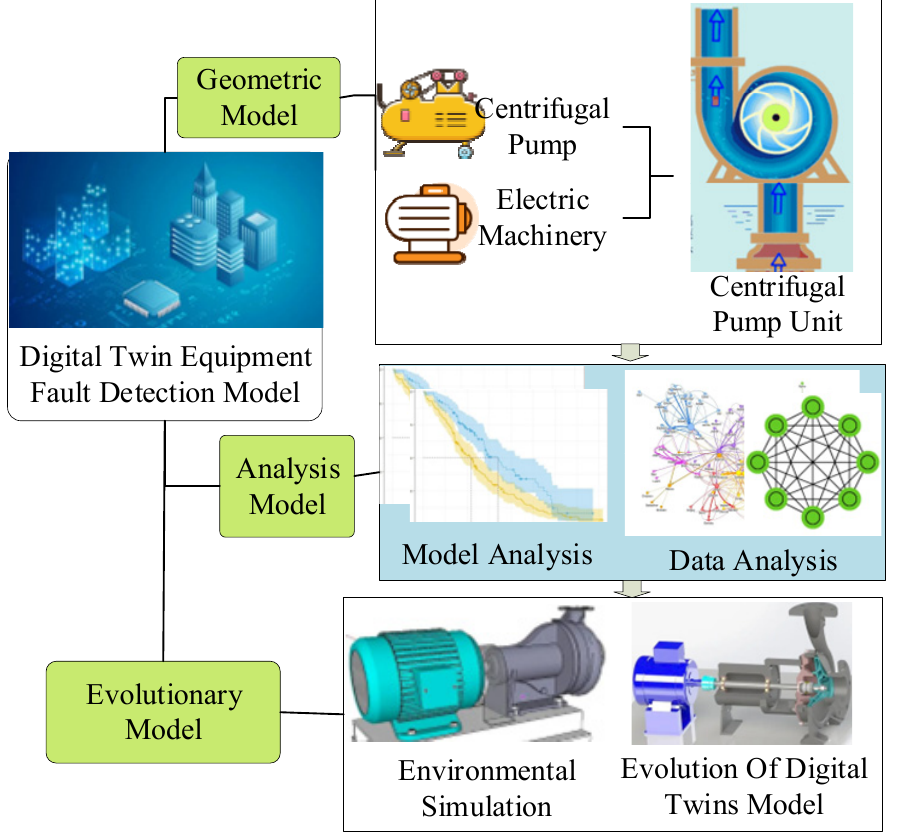
Figure 4. DTT ‐ based applications in centrifugal ‐ pump ‐ oriented fault diagnosis. Figure 4. DTT-based applications in centrifugal-pump-oriented fault